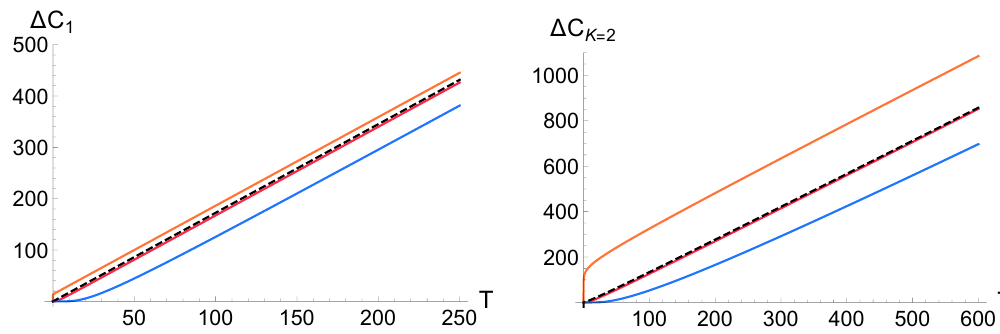
Figure 19 . Complexity of formation for different values of m as a function of the temperature T , with L = 1 , N = 20000 and Ω = 0 . 3 . From the top down m = 10 − 6 (orange), m = 10 (red) and m = 100 (blue). The large T behavior is linear with a slope matching the one obtained in the massless limit and reported in eq. (4.38) and (4.40) for ∆ C 1 and ∆ C κ =2 respectively (dashed black).